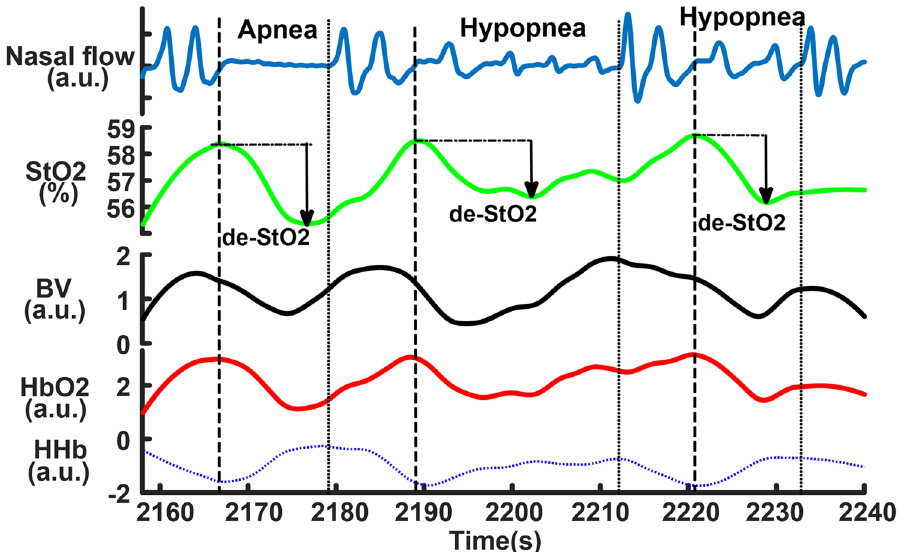
Figure 2. The samples of near-infrared spectroscopy (NIRS) changes in obstructive sleep apneas and hypopneas. The dash lines indicate the start and the end of the events. The cerebral desaturations (de-StO2) are marked in the three events. BV is blood volume. a.u. is arbitrary